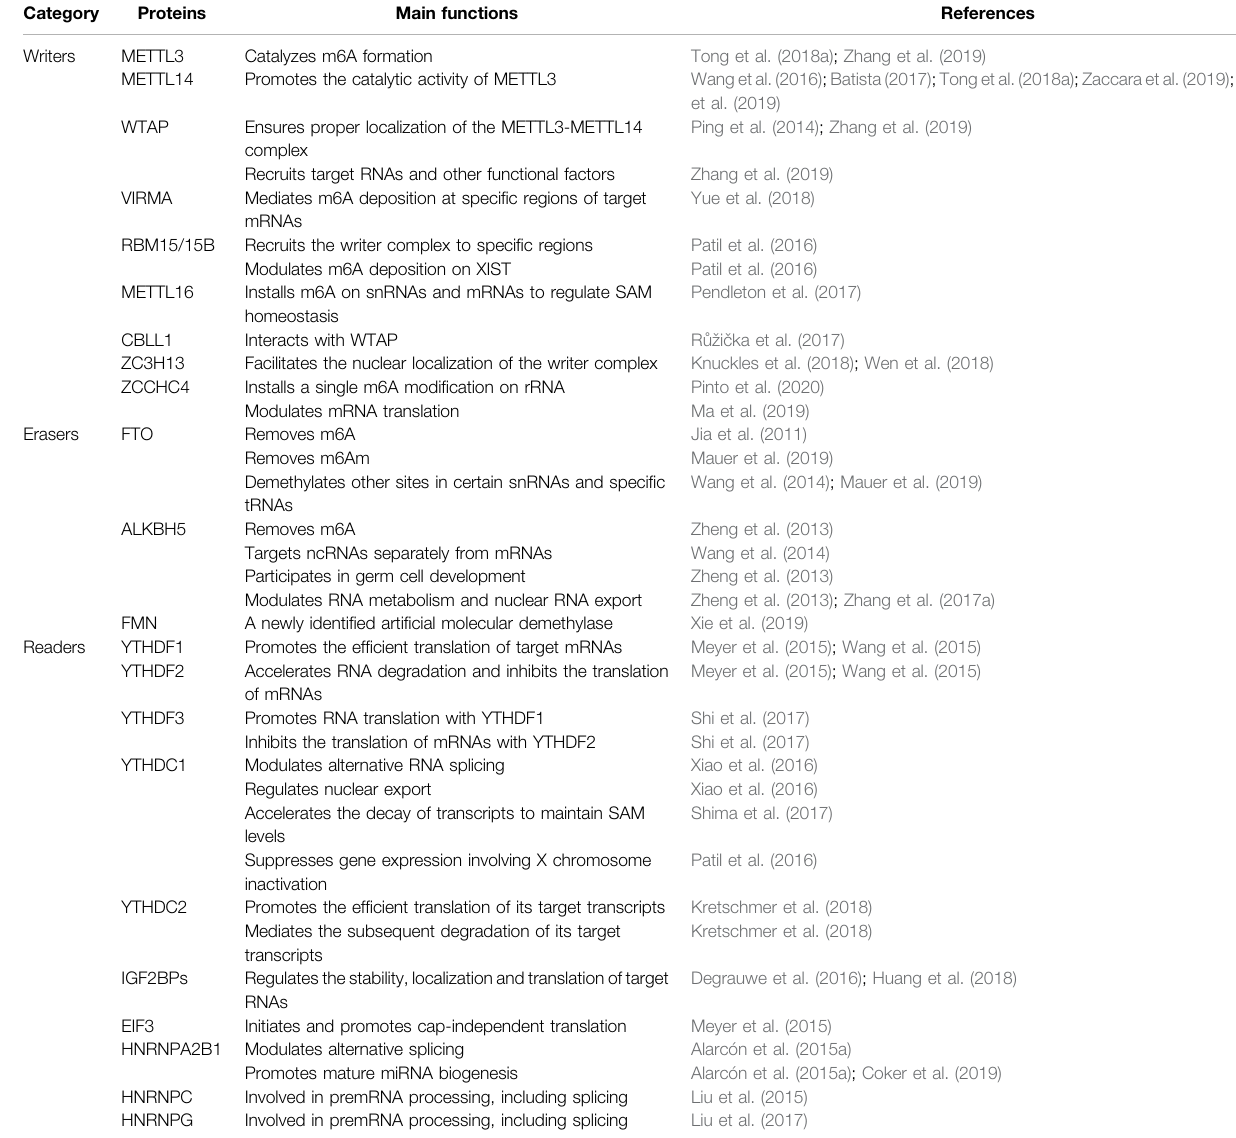
TABLE 1 | Main functions of the three major groups of m6A-related